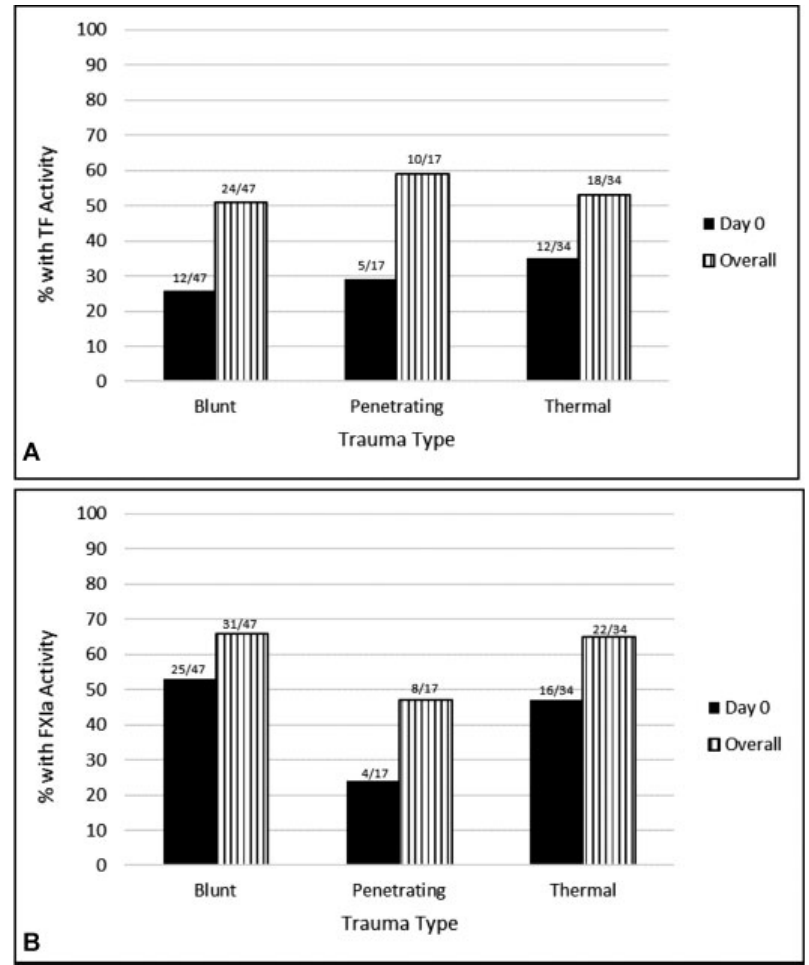
Fig. 1 TFand FXIa activity. Frequency of functional tissue factor (TF) (A) and active factor XIa (FXIa) (B) in plasma from trauma patients at Day 0 and during the entire observation period of 7 days.